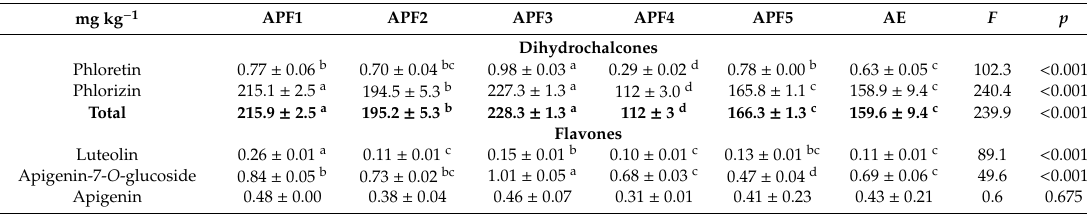
Table 2. Phenolic compounds identified and quantified (mg kg − 1 ) in APF1–5 and AE using HPLC-DAD–MS / MS.